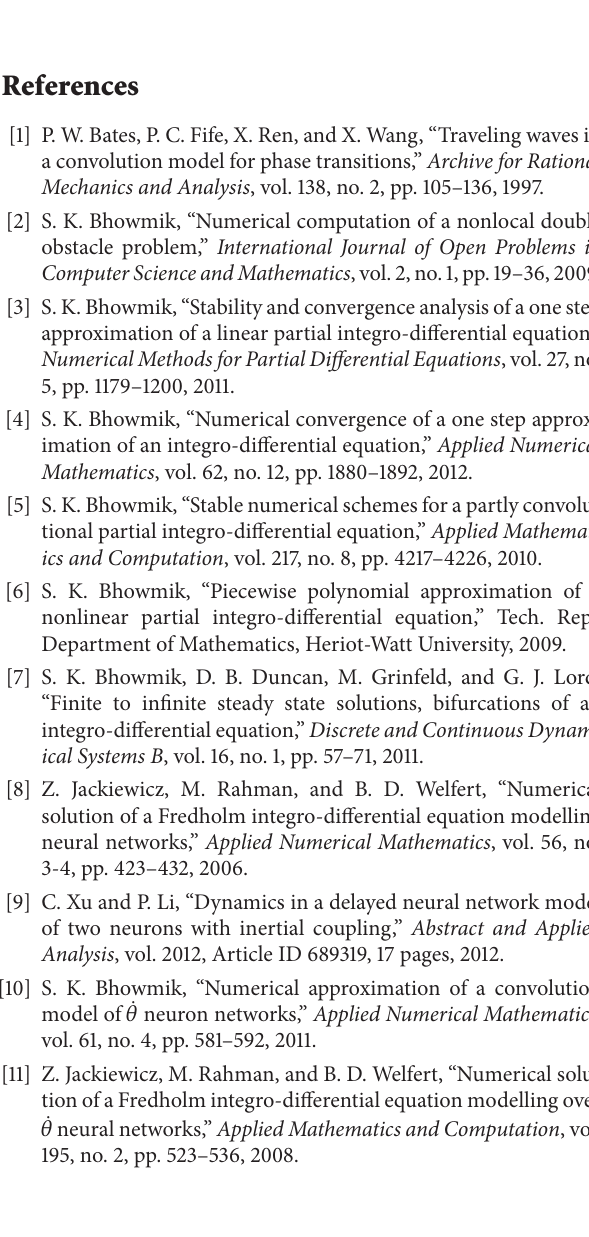
[𝑥 , 𝑥 ] , 𝑖 = 0, 1, 2, . . . , 𝑁 − 1 , for the spatial domain [0, 1] 𝑖 𝑖+1